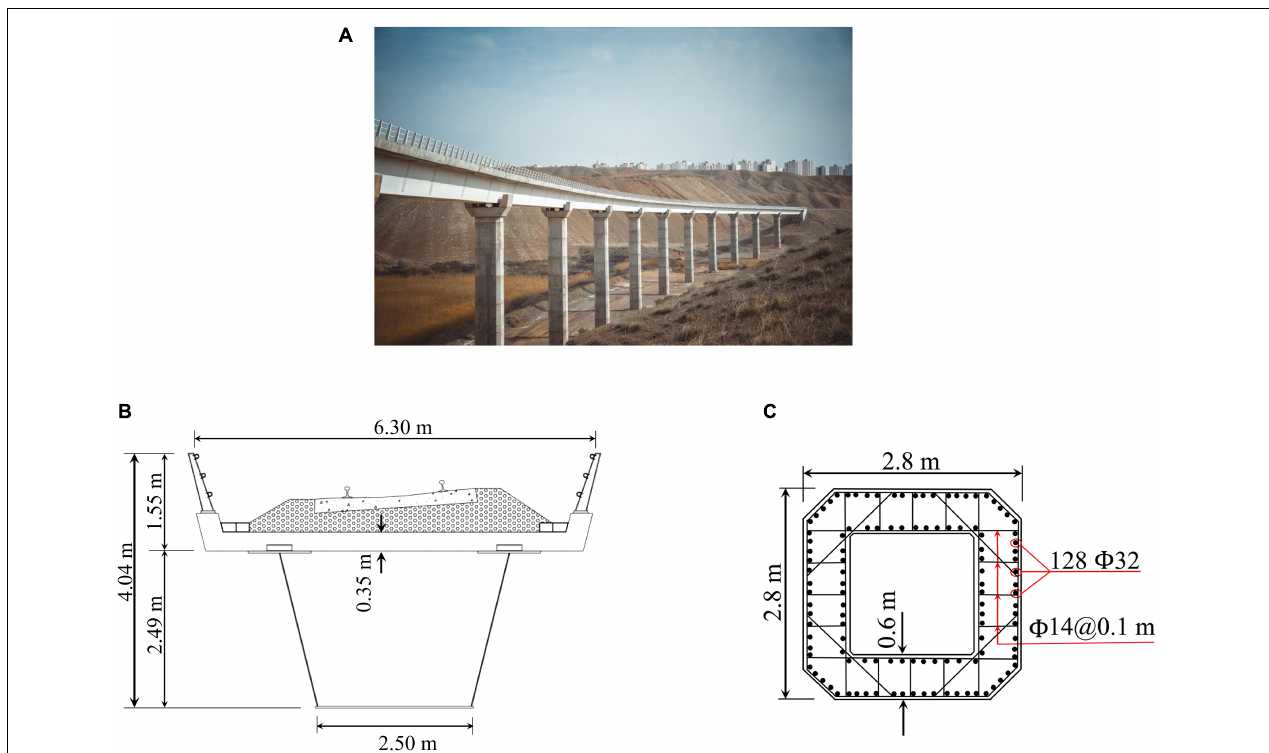
FIGURE 5 | (A) The isolated Rudshur bridge; (B) typical cross-section of the deck; (C) typical reinforcement of the piers at the critical section.